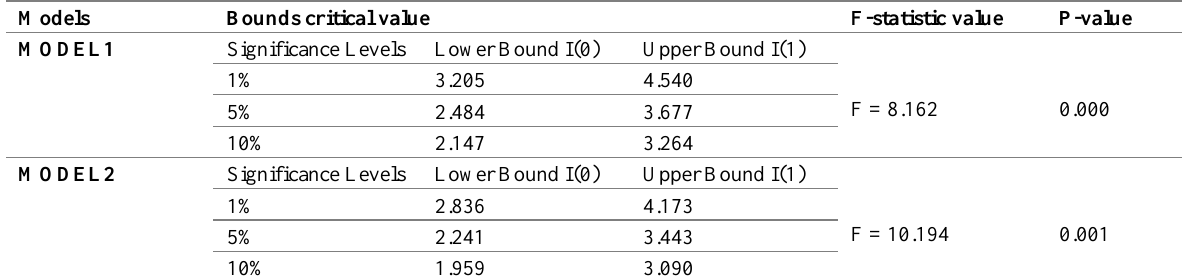
Table 5: Results of The Cointegration Test